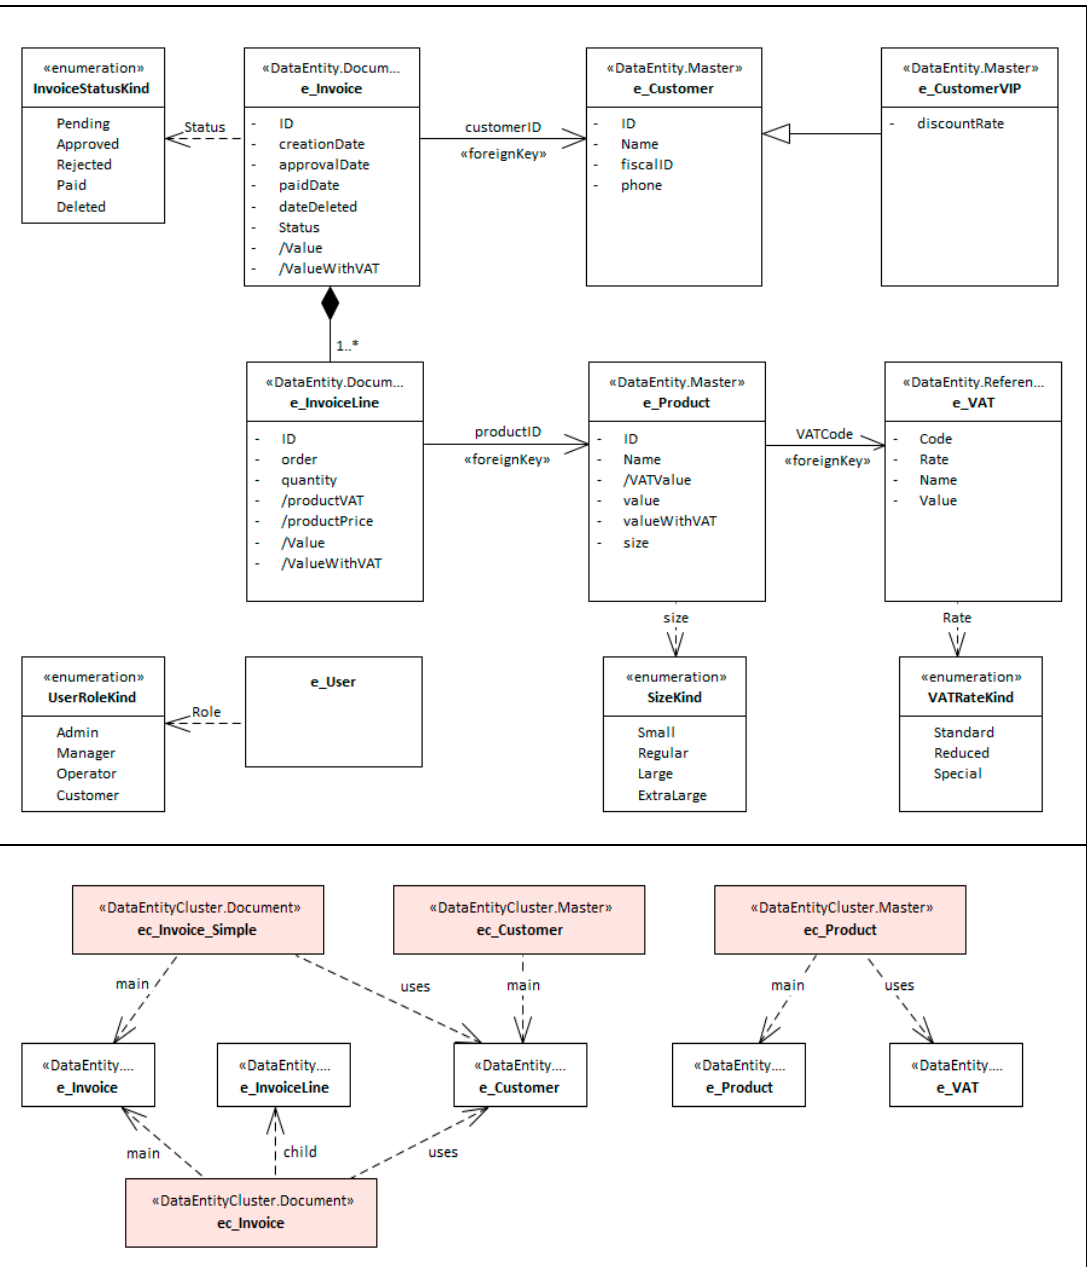
Figure A1 . Domain model of the BillingSystem (based on the UML notation). Figure A1. Domain model of the BillingSystem (based on the UML